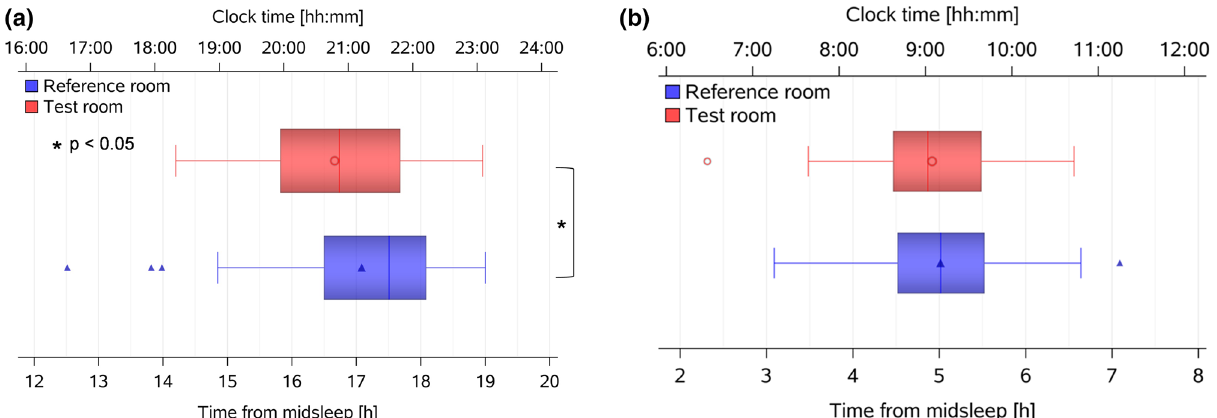
Figure 4. Melatonin secretion onset and offset times. Box plots for ( a ) melatonin secretion onset and ( b ) melatonin secretion offset, averaged across 2 days per condition, and aligned to elapsed time since habitual midsleep for both conditions (corresponding clock time is shown on the upper x-axis). Melatonin onset occurred significantly earlier in the Test room (red symbols; n = 31) than in the Reference room (blue symbols; n = 34; *: p = 0.048). There was no significant difference between both conditions for melatonin offset time. The box plots show mean (red and blue symbols inside the boxes), median (red and blue vertical lines), minimum and maximum values (red and blue horizontal